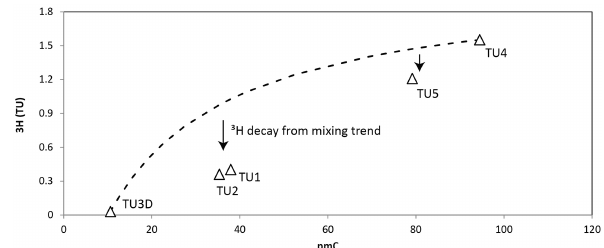
Figure 10. 3 H and 14 C activities of groundwater at Tambo Up- per and predicted trend for mixing between deeper groundwater (TU3D) and shallow groundwater (TU4). Curve based on DIC, 3 H and 14 C activities from Table 2.